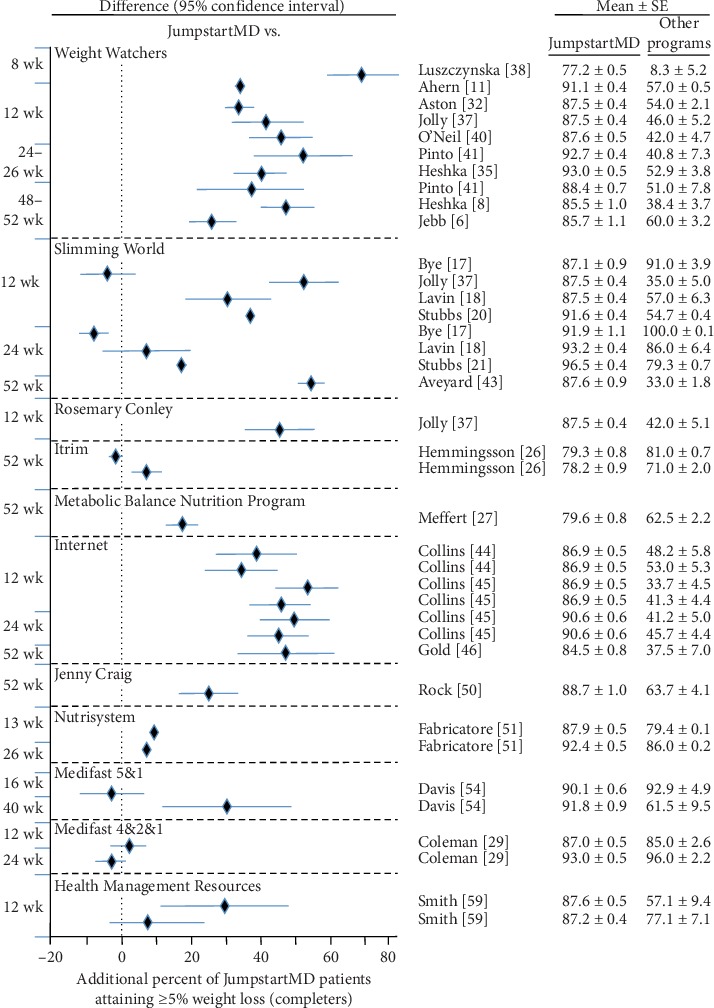
Mean weight loss difference between JumpstartMD and other commercial programs in completers as measured by percent attaining ≥5% weight loss. Positive differences designate greater JumpstartMD weight loss. See legend to Figure 5 for further explanation.